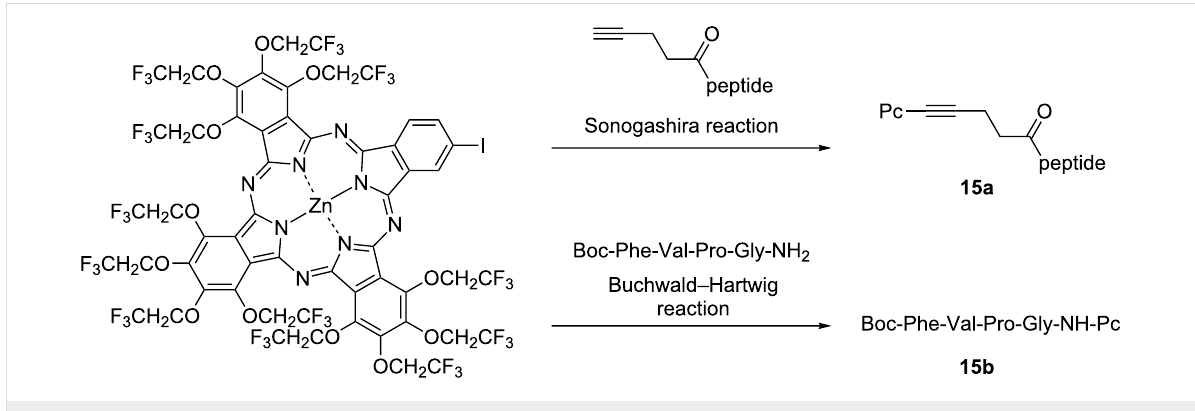
Scheme 5: Synthesis of trifluoroethoxy-substituted phthalocyanines conjugated with peptides.